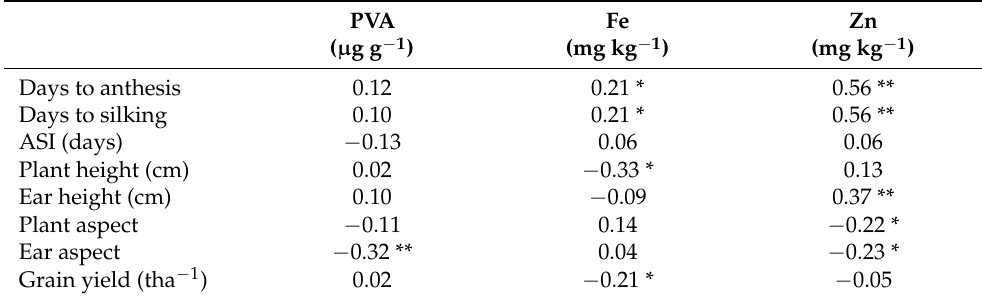
Table 8. Pearson correlation coefficient between micronutrients content and agronomic traits averaged across environments. PVA ( µ g g − 1